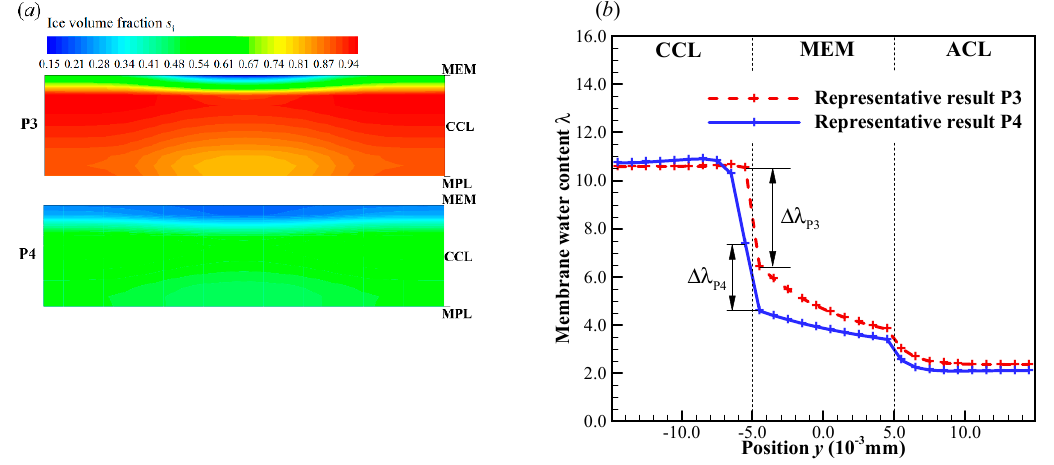
Figure 12. The distribution of ( a ) ice volume fraction in CCL for the processes P3 and P4 at t = 11.9 s, and ( b ) membrane water content along the thickness of CCL, MEM, and ACL. The cell starts from − 20 ◦ C with initial membrane water content λ = 7.8 and current density I = 0.33 A/cm 2 . The cell is supplied with dry hydrogen and oxygen. The stoichiometry ratio of the mass flow rate is 2.0 for both anode and cathode sides. The background pressure is 1.0 atm at both the anode and cathode outlets.